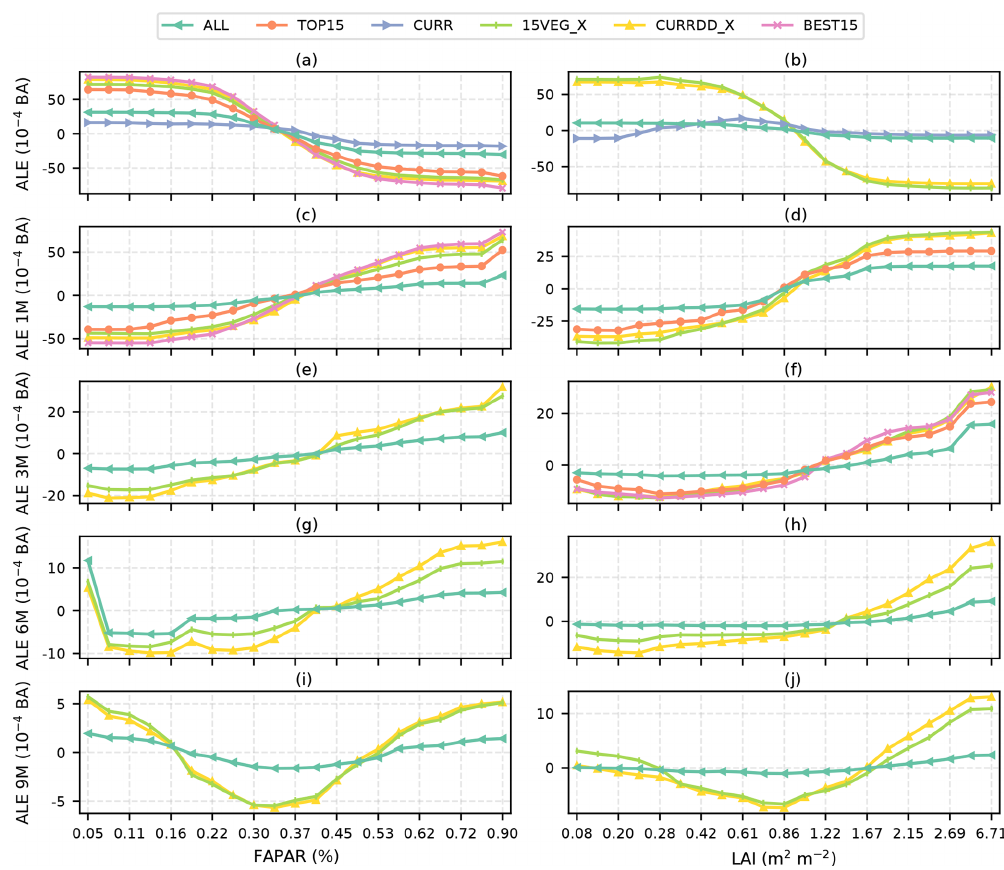
Figure 5. First-order ALEs for different lags ( < 1 year) from all relevant modelling experiments for the relationships between BA and FAPAR (left-hand column) and LAI (right-hand column). Evenly spaced quantiles were used in the construction of the plots. Notably, the relationship between LAI and BA is not modelled consistently by the CURR model (b) , but relationships with BA are generally consistent across models